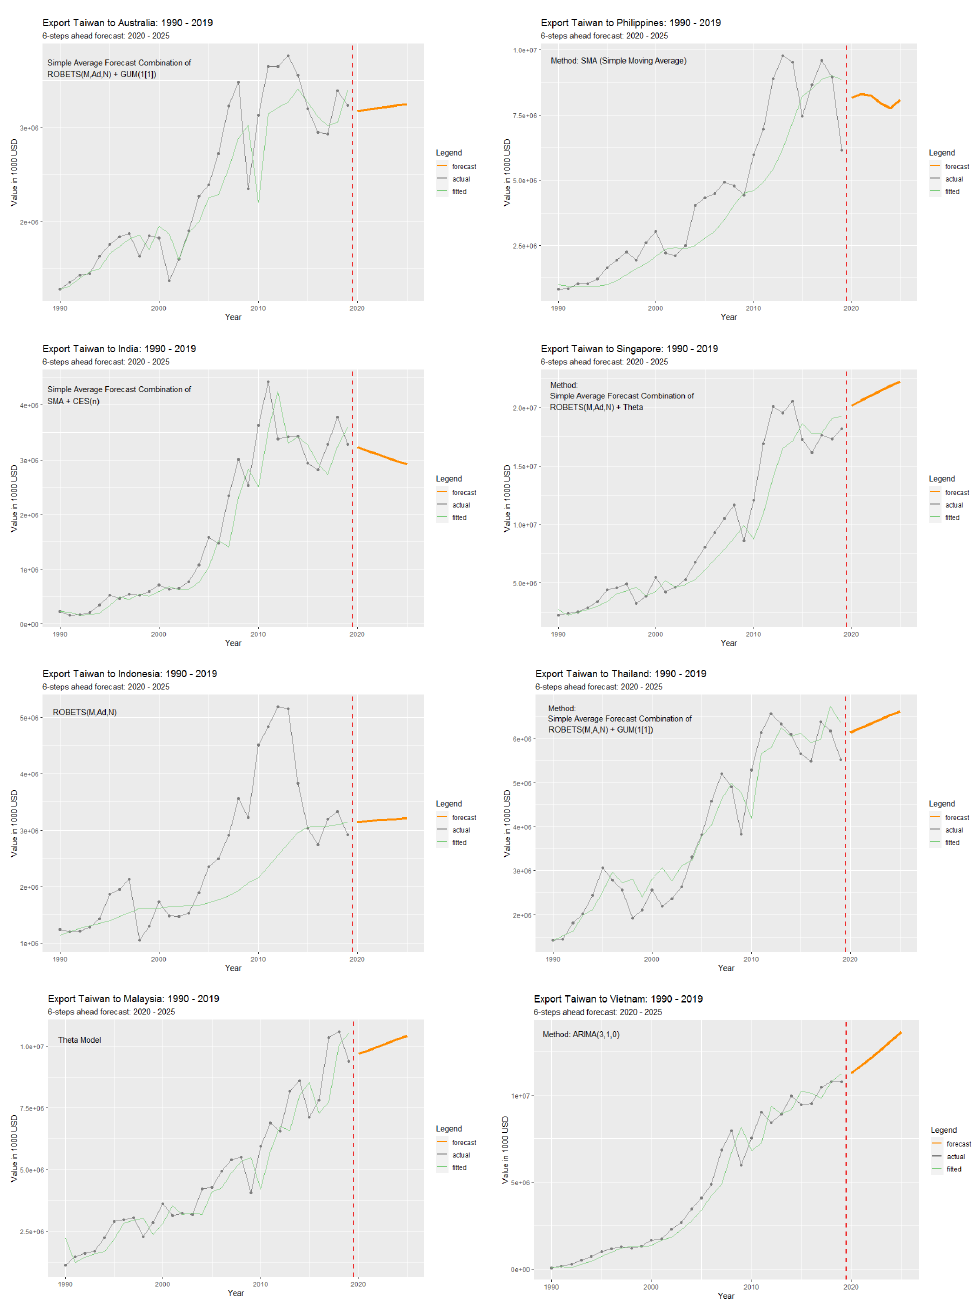
Figure A1. Export forecasts from Taiwan to eight NSP